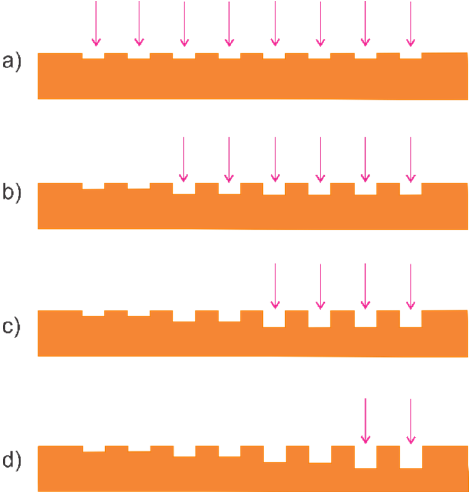
Figure 3. Consecutive reactive ion etching for the NG layer preparation. First RIE etching ( a ) for indent depth of 10 nm, second RIE etching ( b ) for indent depth of 20 nm, third RIE etching ( c ) for indent depth of 30 nm, fourth RIE etching ( d ) for indent depth of 40 nm.